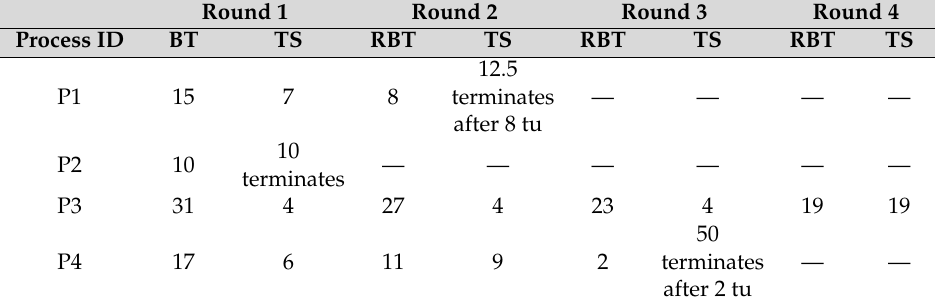
Table 6. Assigning time slice for the running processes in each round.